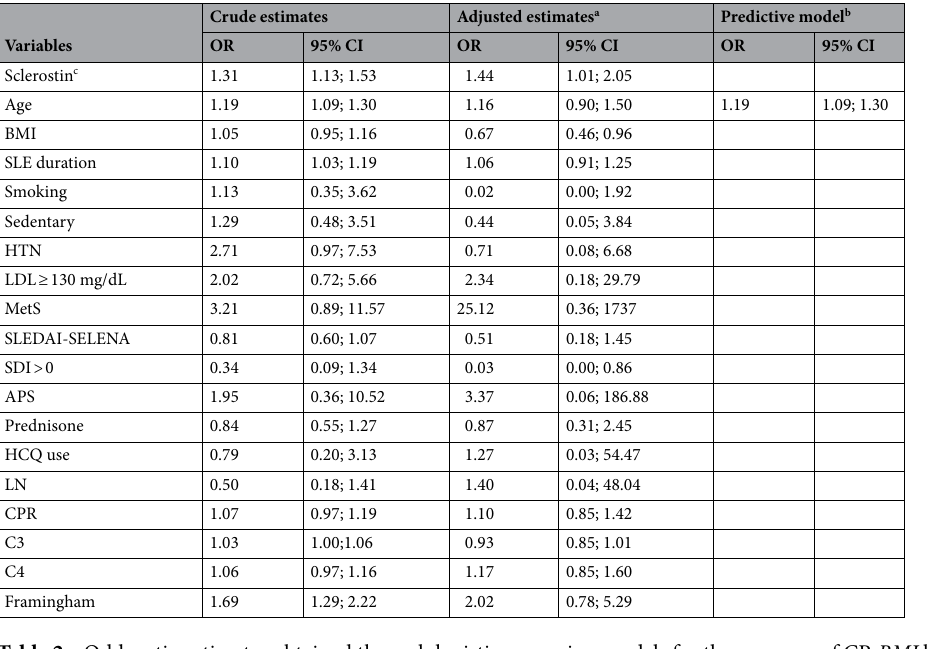
Table 2. Odds ratio estimates obtained through logistic regression models for the presence of CP. BMI body mass index, HTN hypertension, LDL low density lipoprotein, MetS metabolic syndrome, SLEDAI-SELENA Systemic Lupus Erythematosus Disease Activity Index, SDI Systemic Lupus International Collaborating Clinics/American College of Rheumatology Damage Index, APS antiphospholipid syndrome, HCQ hydroxychloroquine, LN lupus nephritis. a The model included all the independent variables shown in the table. b The stepwise model included only variables with a p-to-enter value < 0.05 and a p-to-remove value > 0.10. c Estimated for sclerostin value ×